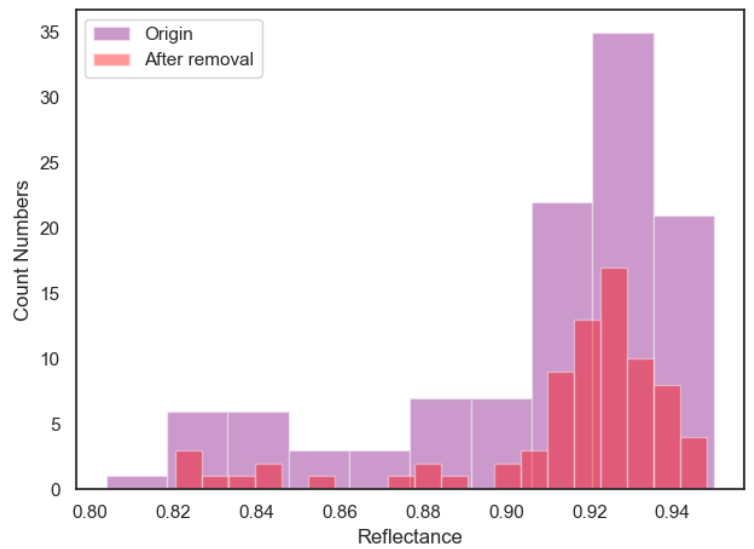
Figure 4. Reflectance histograms of EMI-2 UV2 (340 nm) with and without anomaly removal. After that, the recursive filtering method is introduced to further delete the abnormal measurements possibly due to cloud/shadow contamination [11]. Based on the characteristics of high latitude and large solar zenith angle in the south polar regions, a quadratic polynomial BRDF model of solar zenith angle and surface reflectance is established. The relationship between surface reflectance and the cosine of the solar zenith angle is shown in Equation (1).